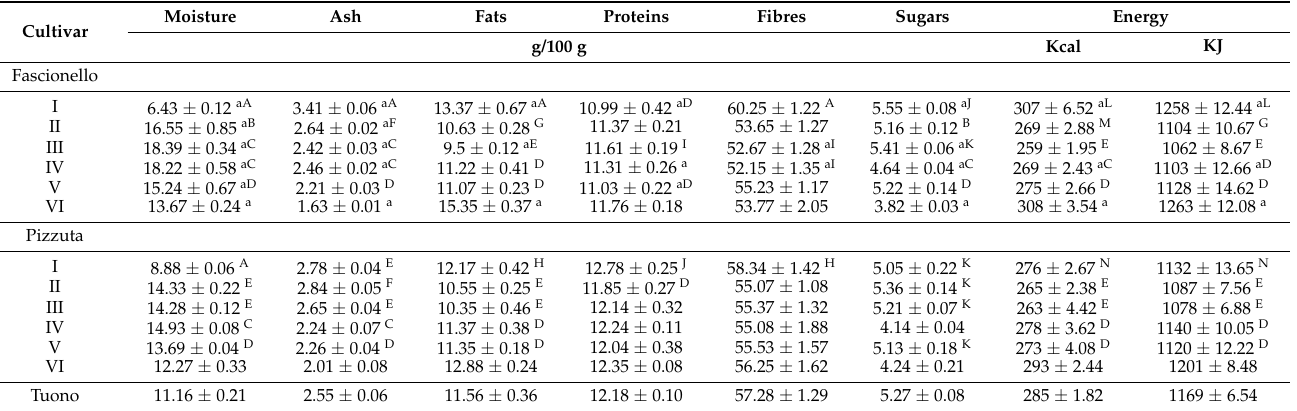
Table 1. Characterization of the nutritional profiles of the blanched skin samples belonging to three different almonds’ cultivars: Fascionello (I–VI), Pizzuta (I–VI), and Tuono. The results, which represent the average ± standard deviation of three independent experiments in triplicate ( n = 3), were expressed as g/100 g of fresh weight, whereas energy values were expressed both in Kcal and KJ. Numbers from I to VI represent different